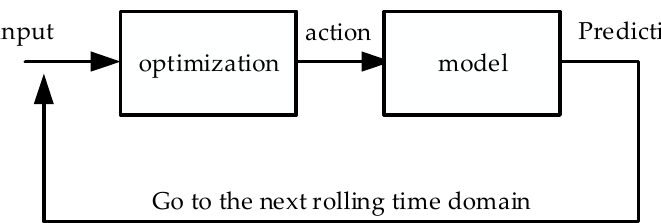
Figure 3. The calculation principle of MPC.